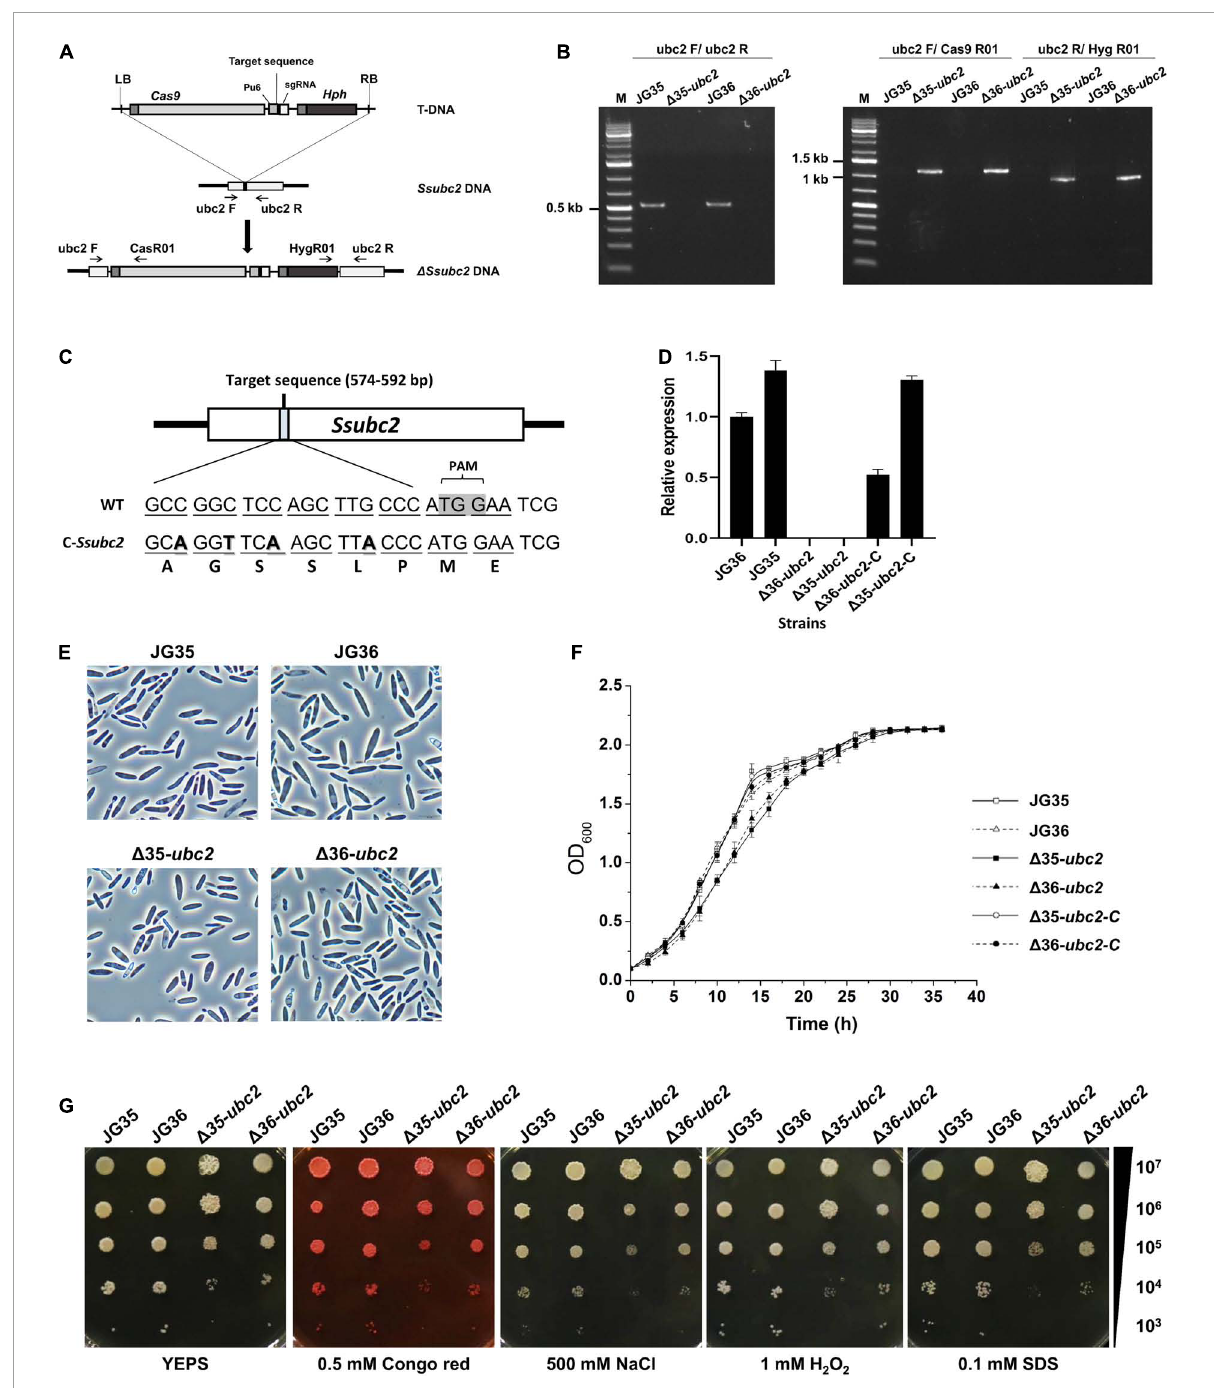
FIGURE2 Characterization of S. scitamineum Ssubc2 deletion and complementation strains. (A) Schematic representation of the Ssubc2 gene disruption strategy. (B) PCR verification of insertion fragments. The primer pair ubc2F/ubc2R was used to amplify the Ss ubc2 gene (538 bp). The primer pairs ubc2F/Cas9R01 and ubc2R/Hyg9R01 were used to amplify the left (1,087 bp) and right (878 bp) ends of the disrupted insertion fragments, respectively. (C) Nucleotide and amino acid sequences of wild-type and base-modified Ssubc2 targets. (D) Quantification of the Ssubc2 gene transcript in (cid:49) Ssubc2 mutants and complementation strains. (E) Microscopic images of basidiospores of wild-type strains and (cid:49) Ssubc2 mutants. Bar, 20 µ m. (F) Growth rates of wild-type strains and (cid:49) Ssubc2 mutants. The strains were cultured in liquid YEPS medium with an initial inoculum of 1 × 10 5 cells mL - 1 at 28 ◦ C with shaking at 200 rpm. Data shown are an average of three independent cultures for each strain, and error bars represent standard deviations. (G) Stress assays for osmolarity, ROS, and cell wall integrity. Cell concentrations are indicated at the right. Test strains were spotted onto YEPS medium supplemented with stressors and incubated at 28 ◦ C for 72